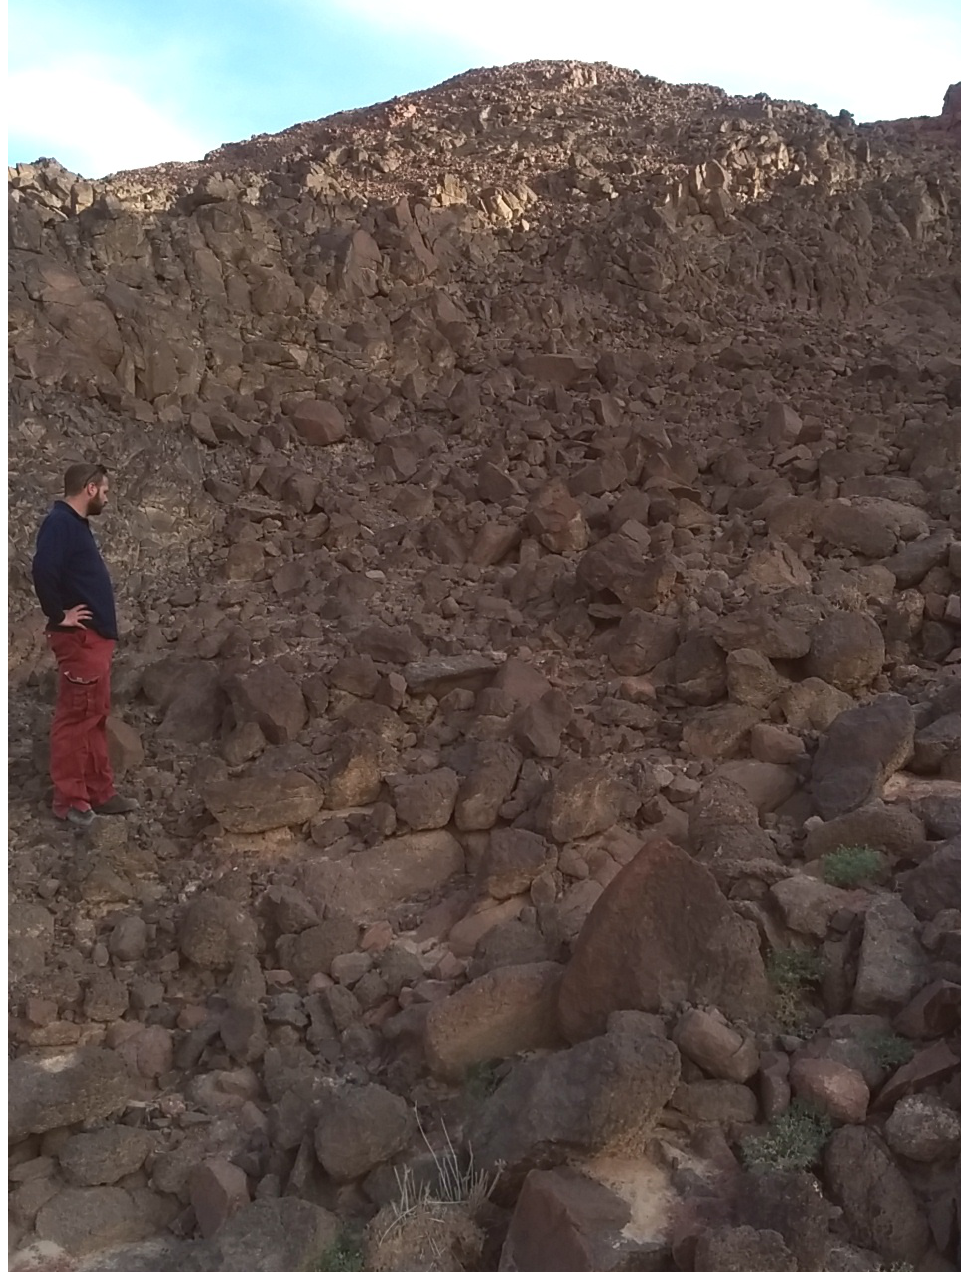
Figure 8. Granite rocks found on the slopes of Mt. Timna; looking east. The photo’s location is marked as #2 in Figure